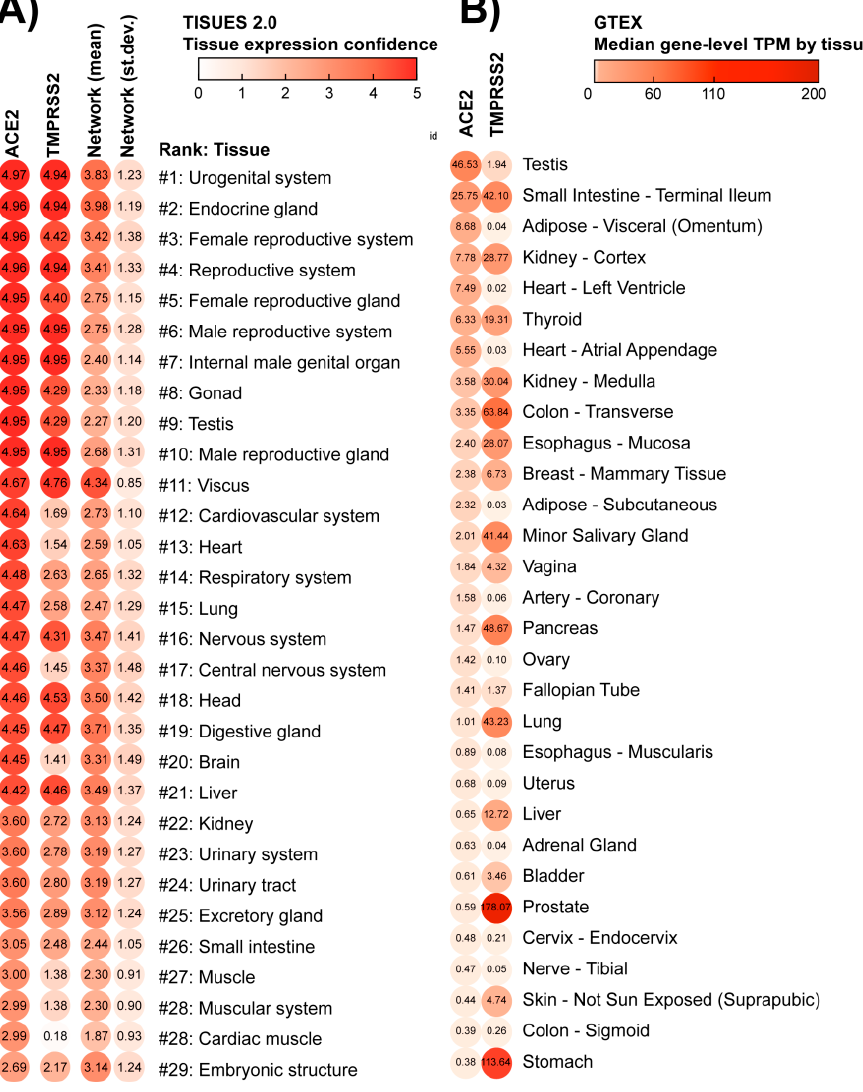
Figure 1. Tissues sorted by the potential of being infected by SARS-CoV-2. These lists of tissues were generated according to the concentration of membrane receptors Angiotensin-Converting Enzyme 2 (ACE2) and Transmembrane Protease Serine 2 (TMPRSS2), obtained from ( A ) TISSUES 2.0 database expression confidence values, and ( B ) Genotype-Tissue Expression (GTEx) project Transcripts Per Million (TPM) values. The virus starts the cell infection by binding to ACE2, a major hub in multiple physiological processes: this binding can block ACE2 network activity. However, the virus will enter the host cell when TMPRSS2 cleavages ACE2. The first column depicts the average gene and protein expression confidence for the ACE2 receptor; the second column depicts the average expression confidence of TMPRSS2. The mean and standard deviation of expression confidence across 69 genes / proteins of the ACE2 network are presented in the third and fourth columns of panel A, respectively. Notice that the lungs and respiratory system are ranked as #14–15 in the TISSUES 2.0 list, while the heart and cardiovascular system are #12–13. Nervous and reproductive systems are ranked as #16–17 and #1–10,